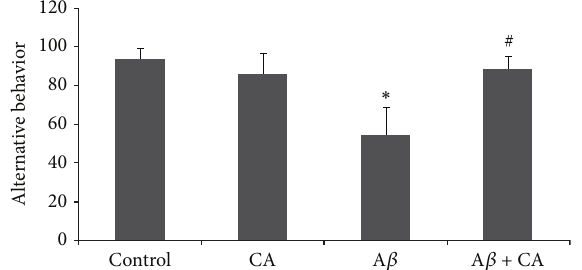
Figure 2: The percent of alternation behavior in the experimental groups (control, CA: carnosic acid, A 𝛽 : Amyloid beta, and A 𝛽 + CA: carnosic acid + A 𝛽 ) (mean ± SEM): ∗ 𝑃 < 0.05 compared to the control group and # 𝑃 < 0.05 compared to the A 𝛽